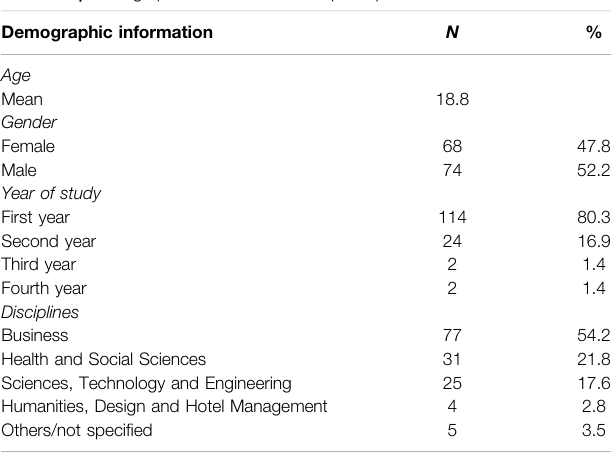
TABLE 3 | Demographic information of the